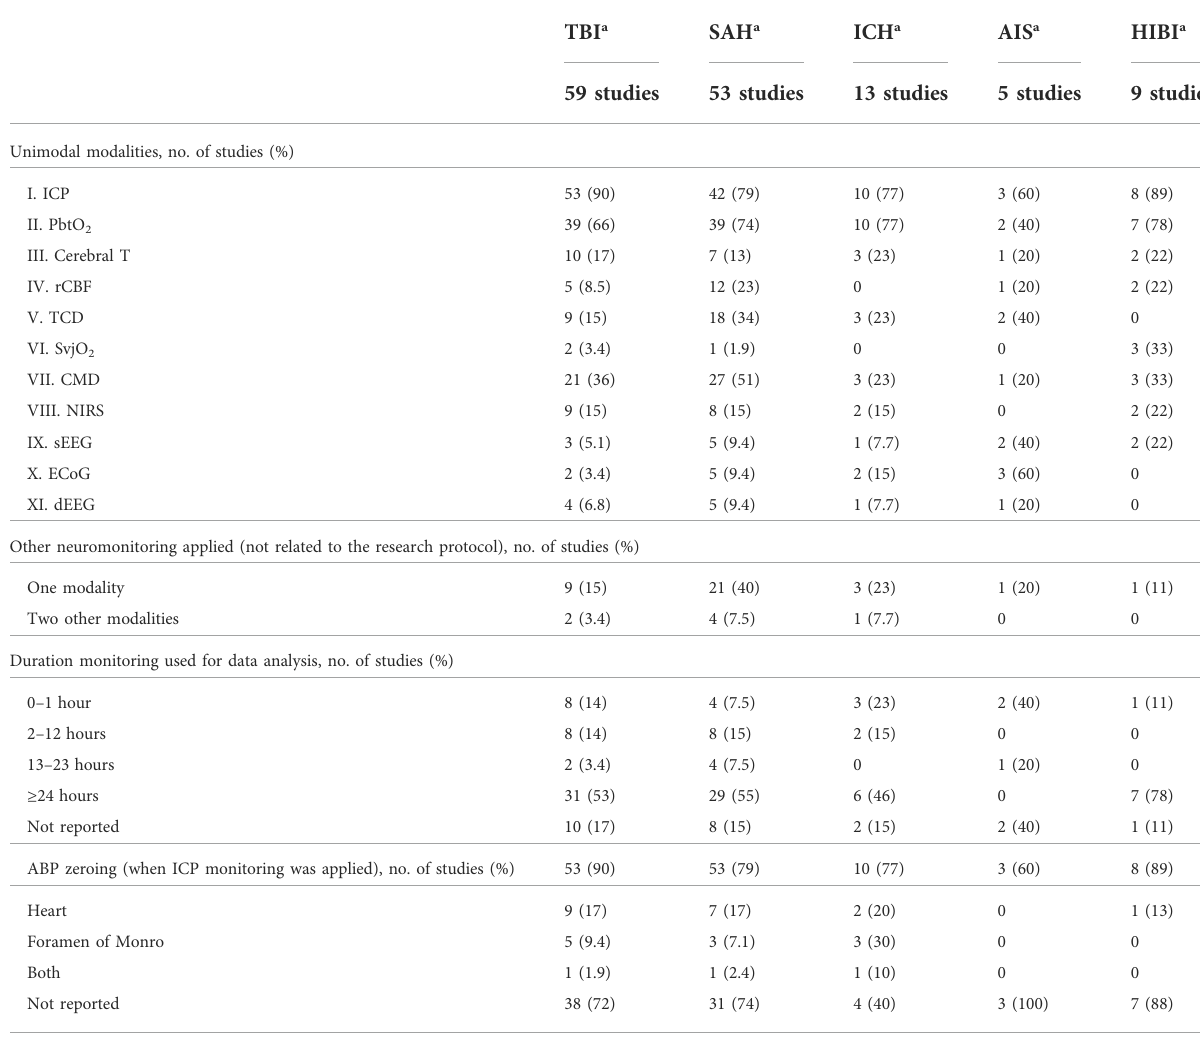
TABLE 1 Monitoring setting of cerebral multimodality monitoring studies (112